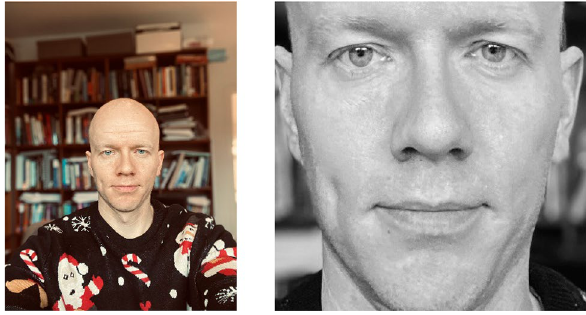
Figure 1. Example of cropping an